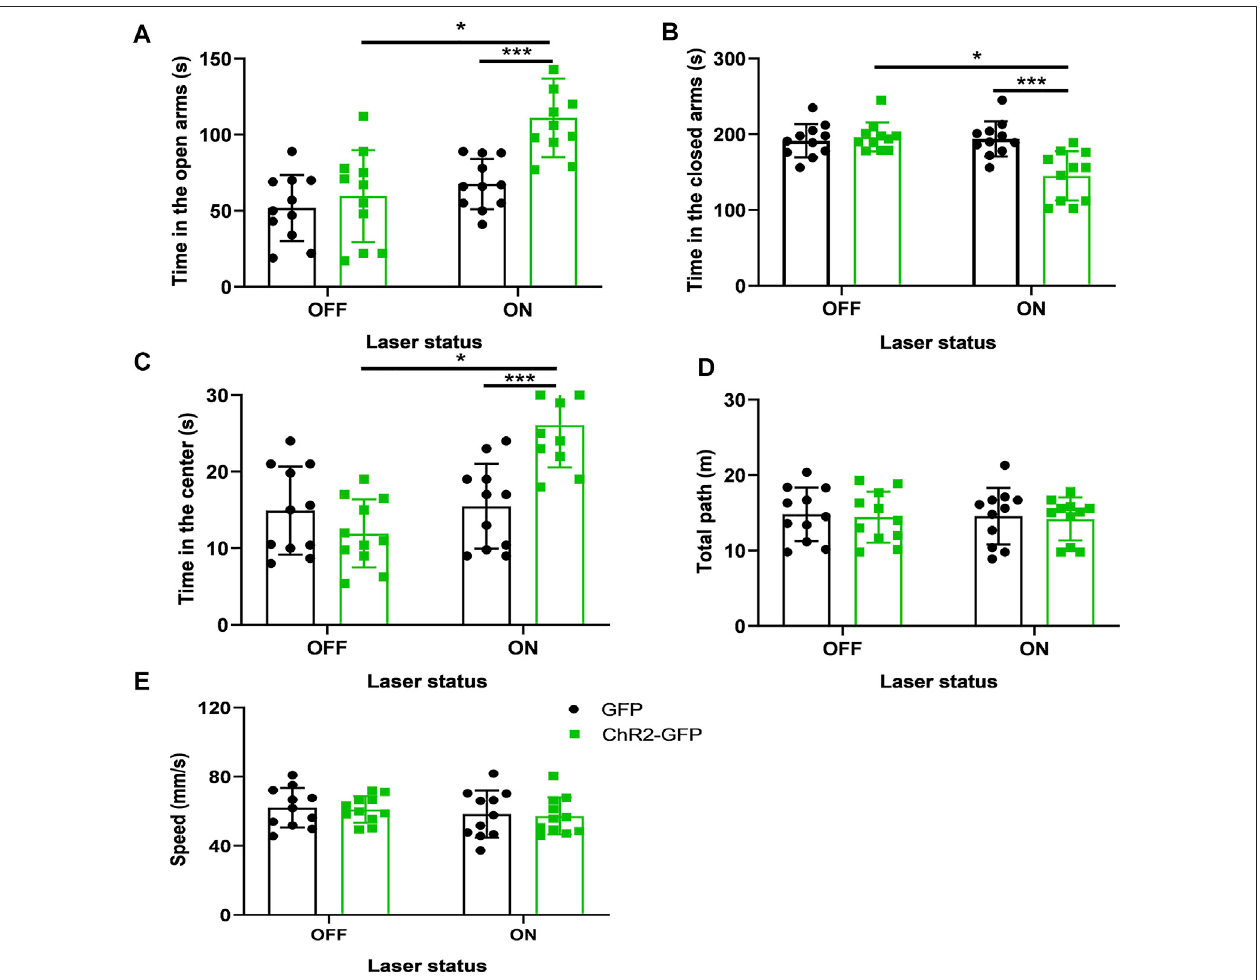
FIGURE4| LTDofthePVN-Cgneuralcircuitreducesanxiety-likebehaviorsinmice. (A) InhibitionofthePVNprojectionstotheCgincreasedtheopen-armstimein the EPMtest. (B) InhibitionofthePVN projectionstothe Cgdecreased theclose-arms time inthe EPMtest. (C) Inhibition ofthePVN projectionstothe Cgincreased the timeincenterintheopen- fi eldtest. (D) InhibitionofthePVNprojectionstotheCgdidnotaffectthemovingdistanceofmice. (E) InhibitionofthePVNprojectionstotheCg did not affect the speed of mice (* p < .05, ** p < .01, *** p < .001, n = 11/group. Error bars denote SEM. Two-way ANOVA test).